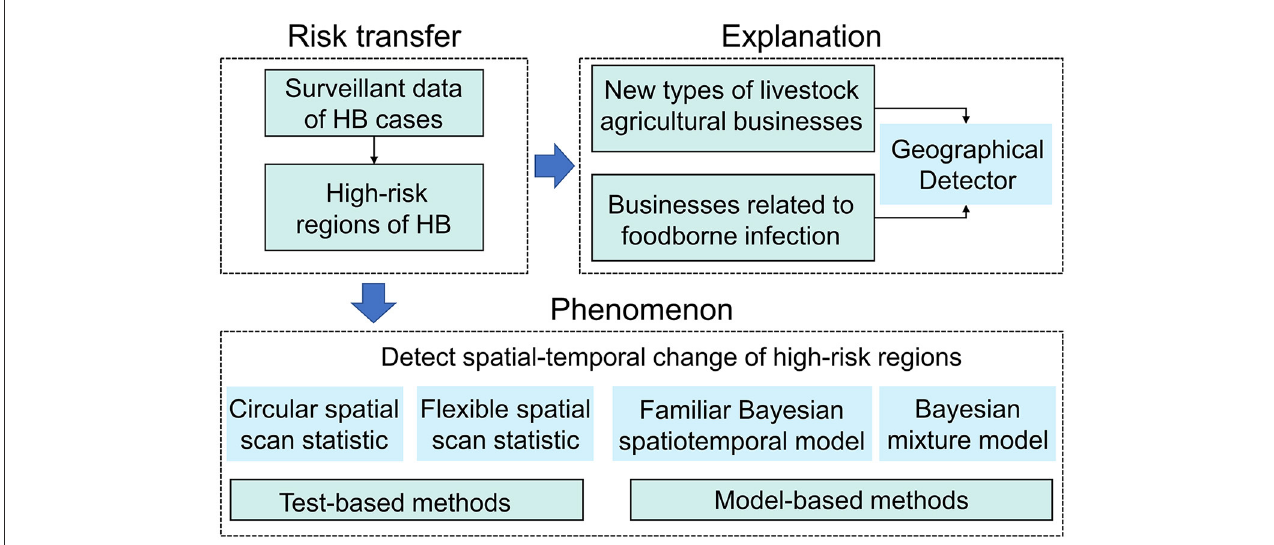
FIGURE3 Research methods used to investigate the phenomenon and explanation of HB risk transfer. Test-based methods could provide spatiotemporal distribution of clusters in high-risk areas of HB and model-based approach can estimate posterior relative risk changes of HB. Geographical detector could quantify the explanatory power of impact factors on HB spatial